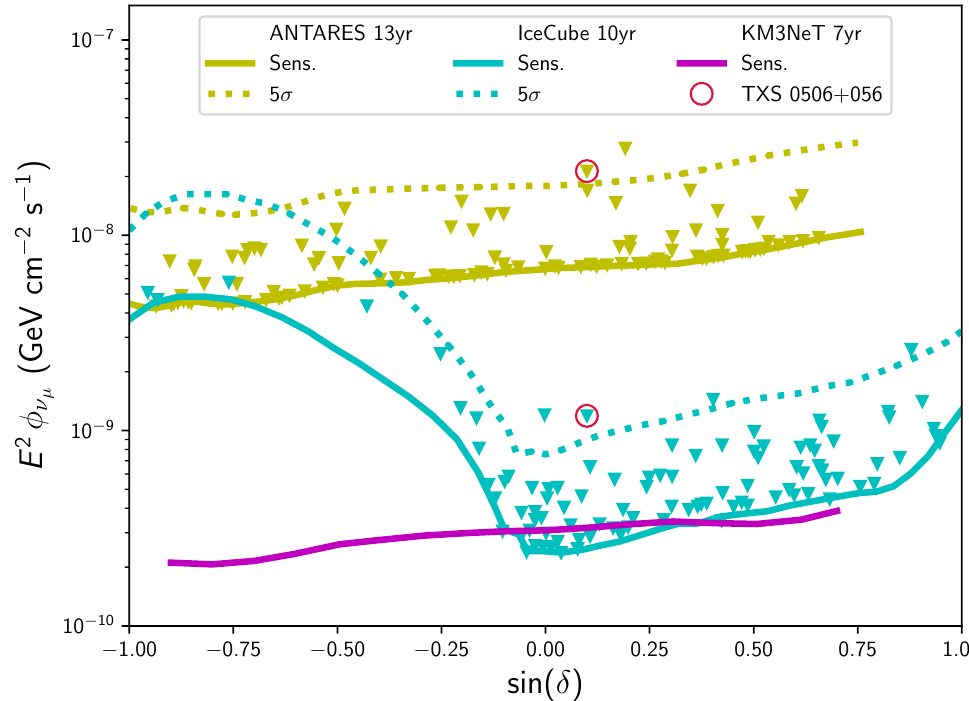
Figure 2. Differential energy flux sensitivity curves as a function of the sine of the declination, δ , from current neutrino telescopes: ANTARES [28], IceCube [69] and KM3NeT [70], with flux upper limits for individual source candidates (triangles) in ANTARES and IceCube. Notice that the sensitivity of KM3NeT is obtained assuming a fully operational detector. Differences in curve shapes depend mostly on detector latitudes due to the dominant event topologies (muon tracks) and backgrounds in play (e.g., atmospheric